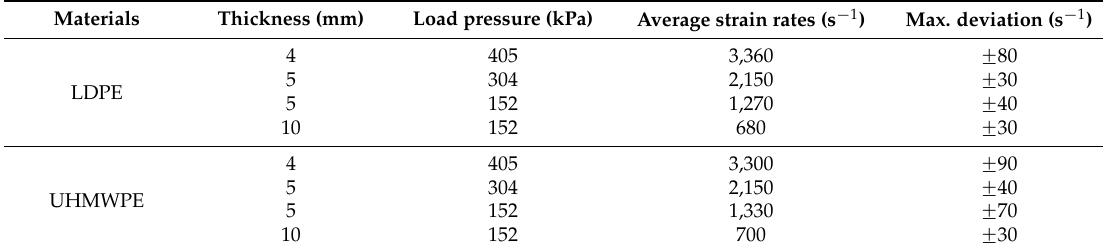
Table 2. Thickness of the specimens and load pressure.